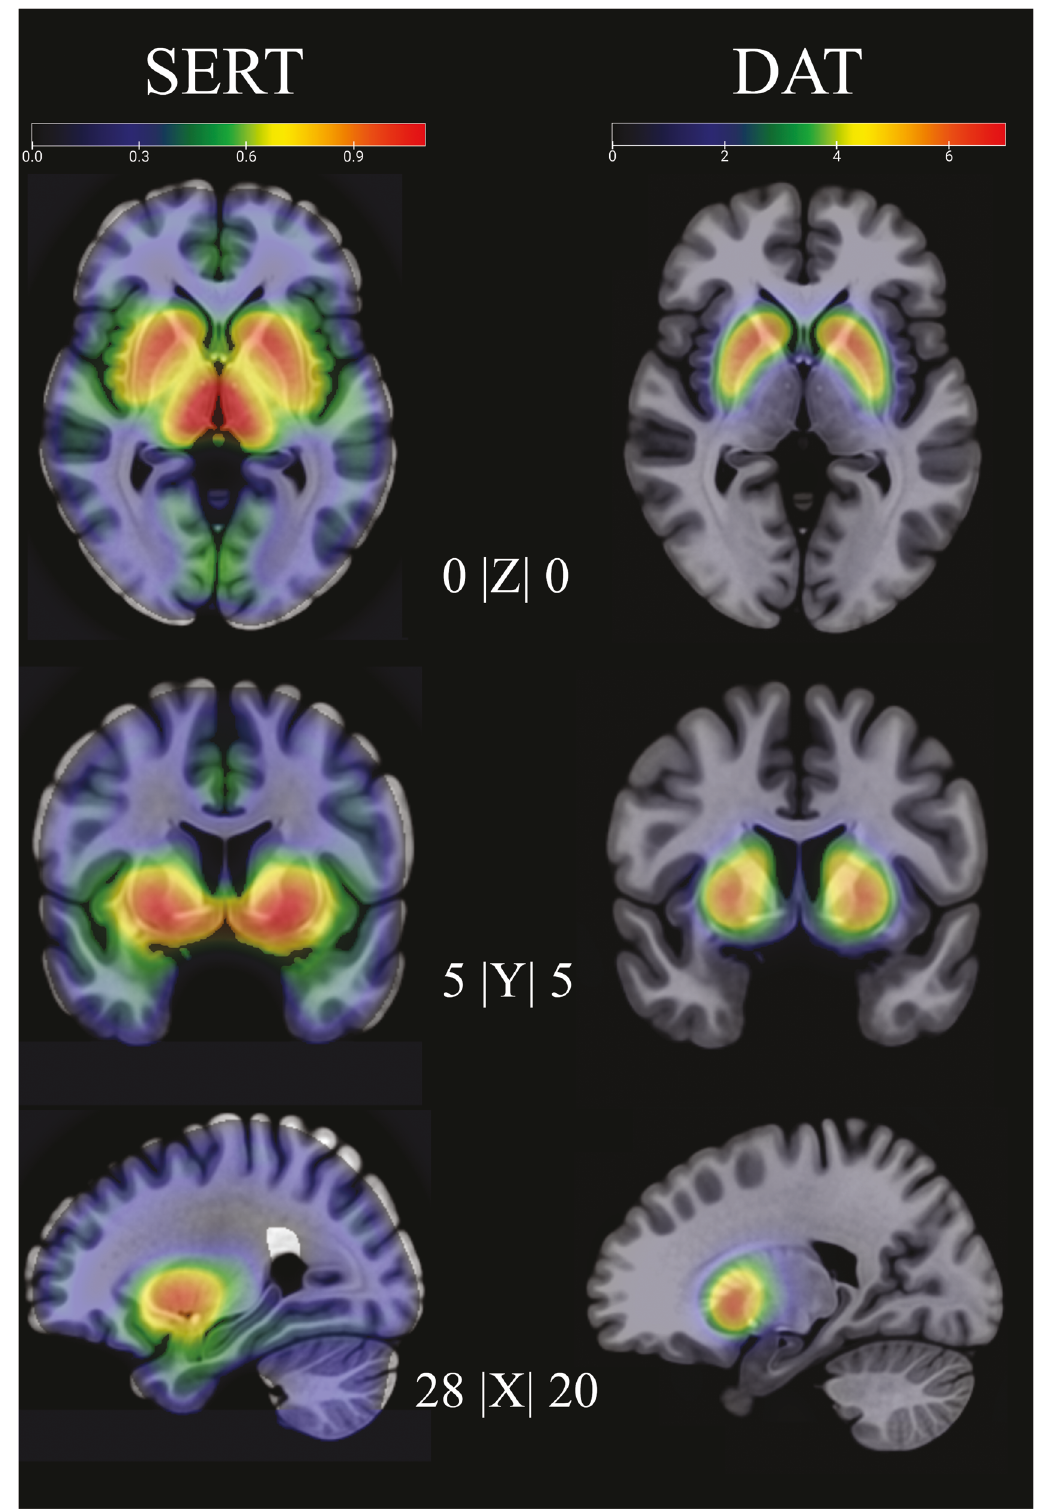
Fig. 1 Whole sample pre-treatment SERT and DAT binding. Left panel shows serotonin transporter non-displaceable binding potential pre treatment and the rightpanel shows non-displaceable binding potential for the dopamine